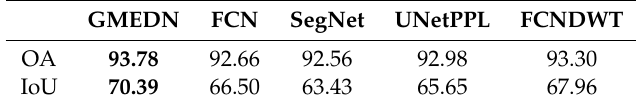
Table 2. IoU and OA scores of different methods counted by the Massachusetts dataset